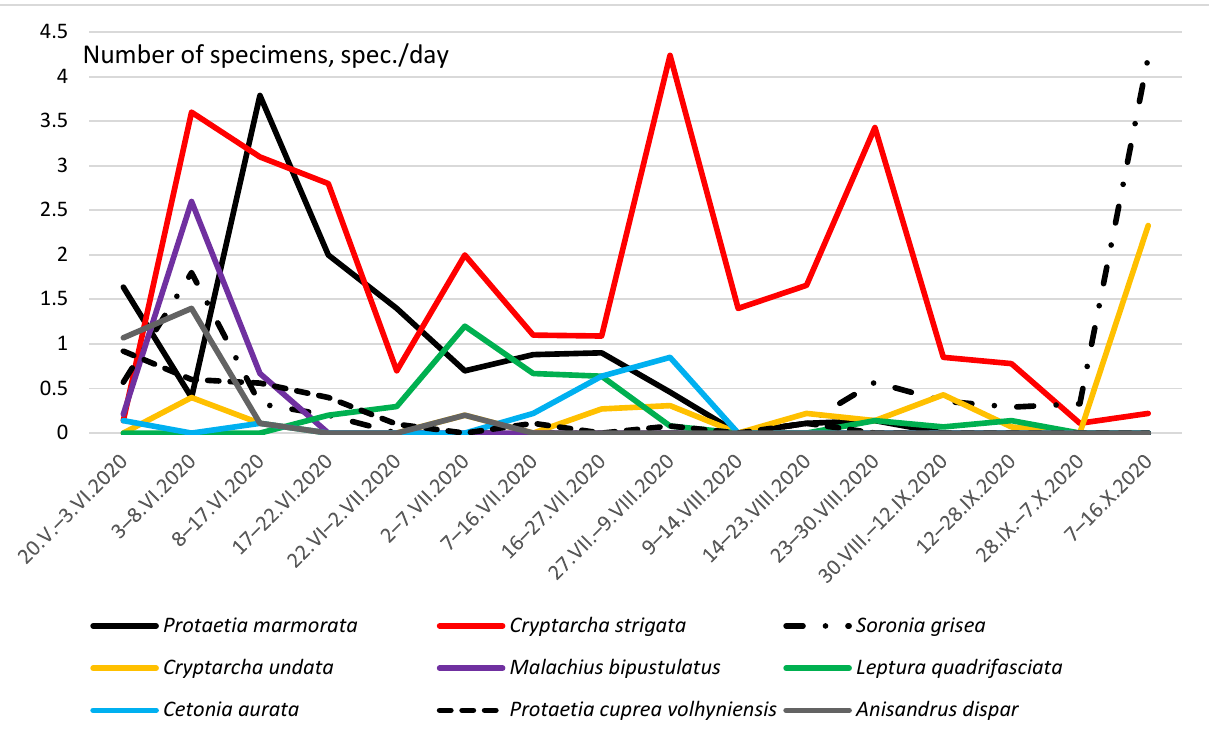
Figure 7. The total seasonal dynamics of the number of nine Coleoptera taxon in a glade in the forest. The seasonal dynamics of P. marmorata abundance were more regular (Figures 6 and